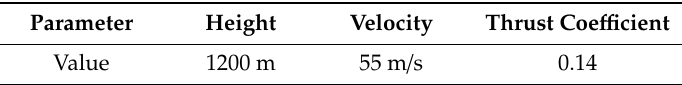
Table 7. Initial flight conditions of “all iced” aircraft.